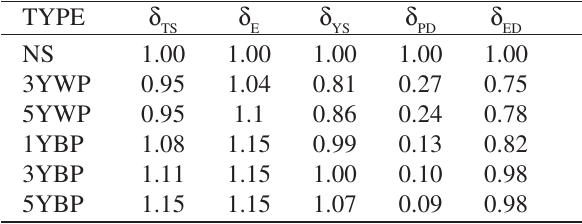
Table 1. Values of parameters ( δ ) of traction tests, where δ δ and δ are the comparative mean parameters of tensile YS, PD ED strength, of modulus of elasticity, of yield strength, of plastic de- formation and of the elastic deformation.